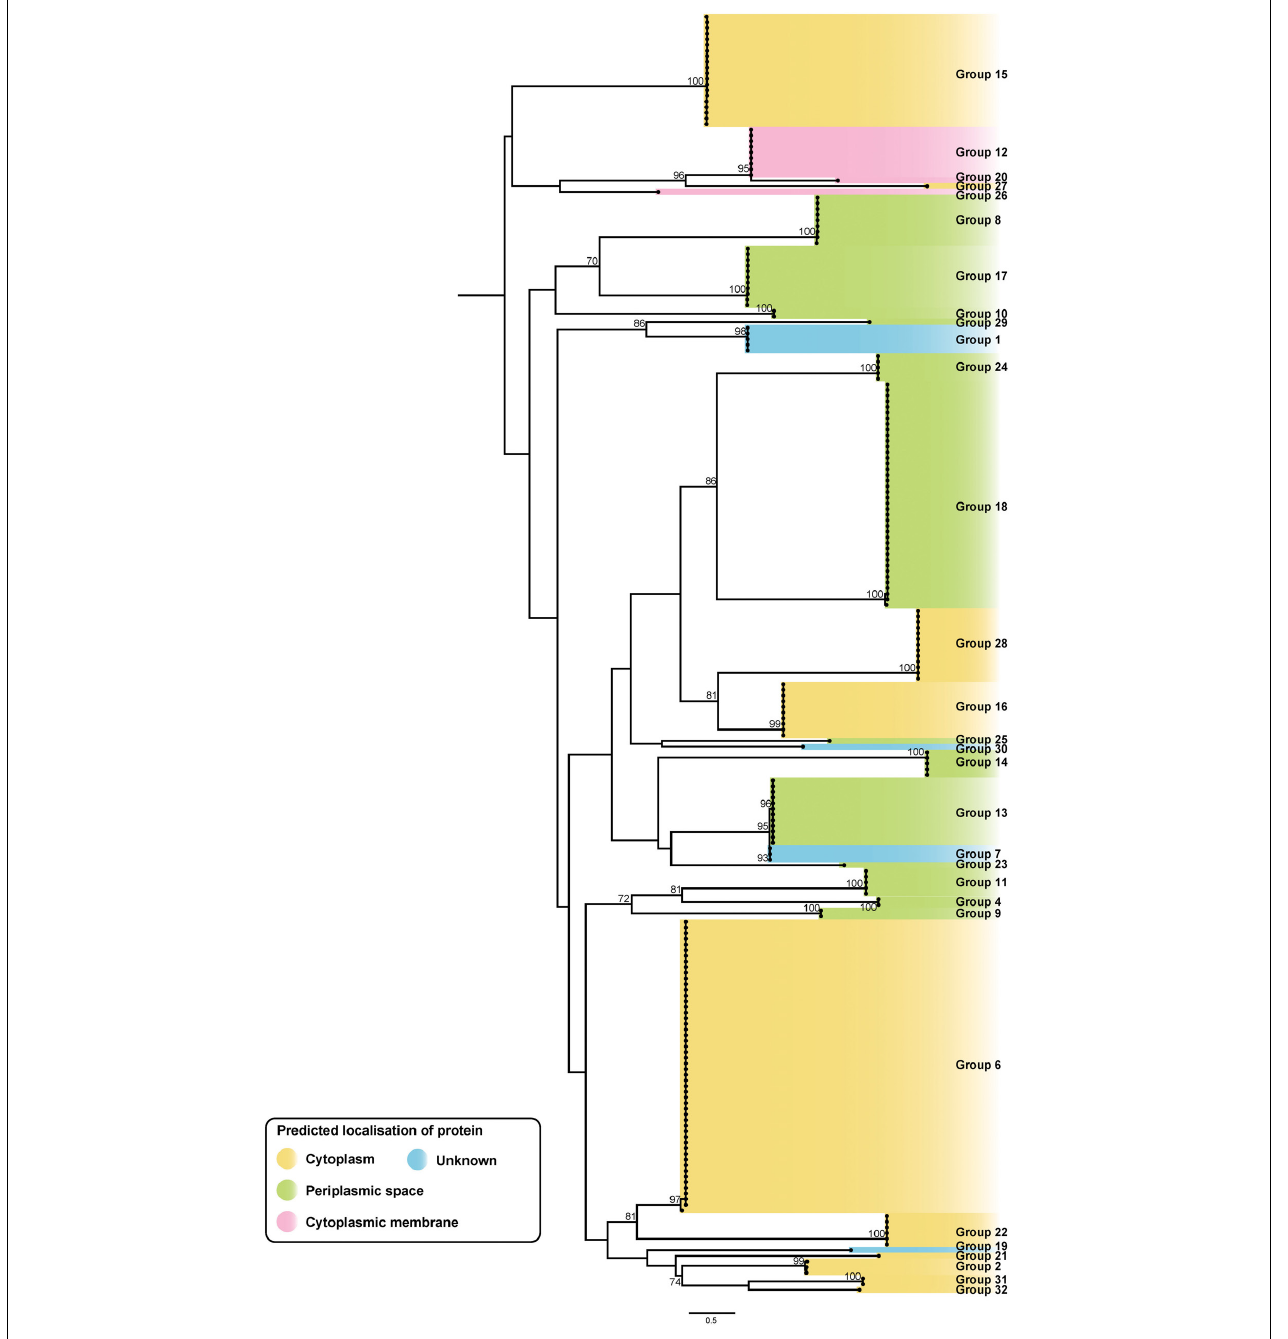
FIGURE 8 | ML phylogenetic tree of putative A. baumannii T6SS immunity proteins. The tree was generated from amino acid sequences using the general ‘variable time’ matrix with the discrete Gamma model (VT + F + G4). Branches have been named according to the effector loci to which the immunity proteins correspond. The scale bar represents the number of amino acid substitutions. Branch support values ≥ 70 (UFBoot) are shown at all major nodes. Colored highlight denotes expected localization of the proteins ( Supplementary Files S3e , S4e